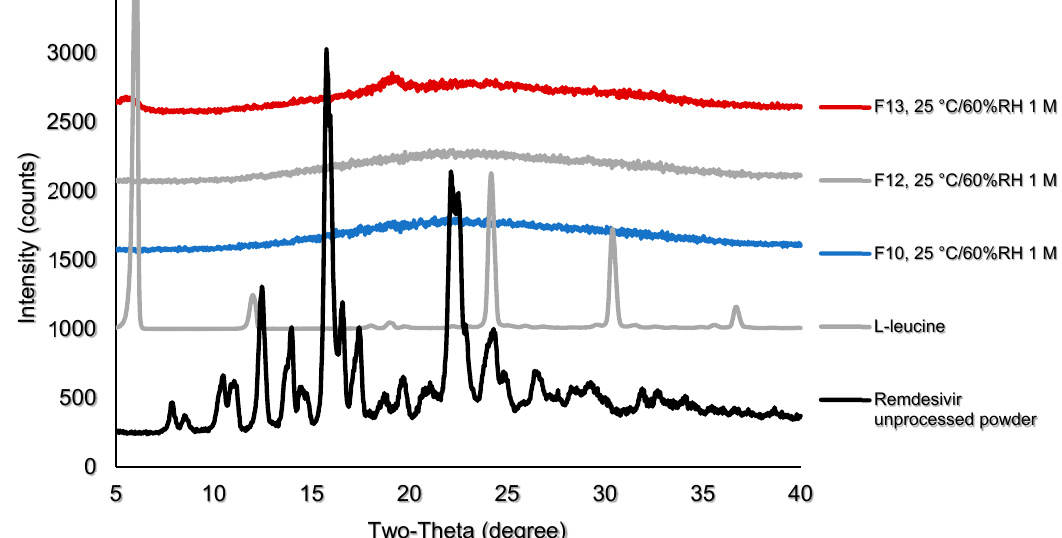
Figure 6. XRD di ff ractograms of F10, F12, and F13 after storage at 25 ◦ C / 60% Figure 6. XRD diffractograms of F10, F12, and F13 after storage at 25 °C/60% RH.